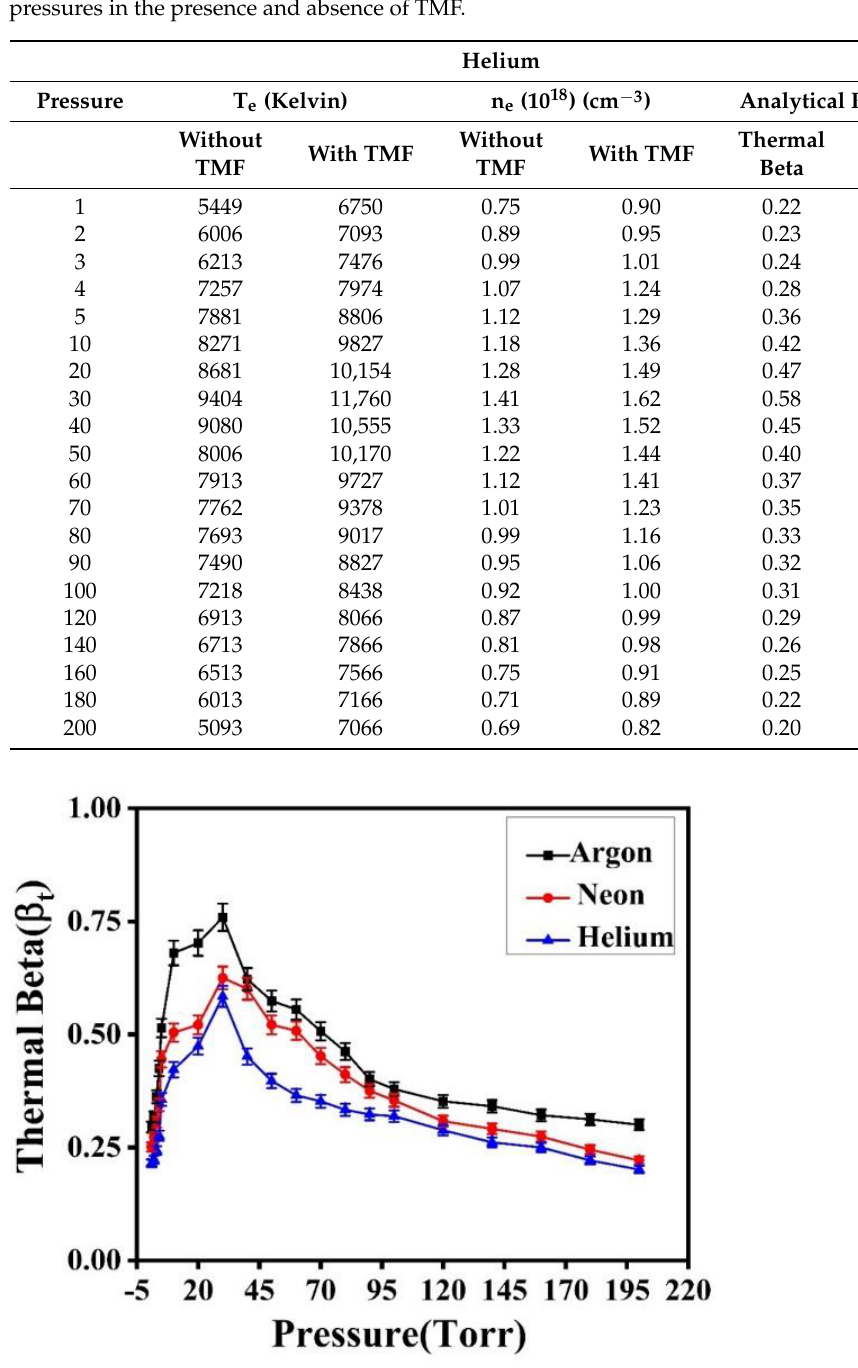
rounding gases. Figure 9. The fluctuation in directional beta of laser-induced Cu alloy plasma at different pressures in Ar, Ne, and He environments at 3.8 GW/cm 2 ns laser irradiation.